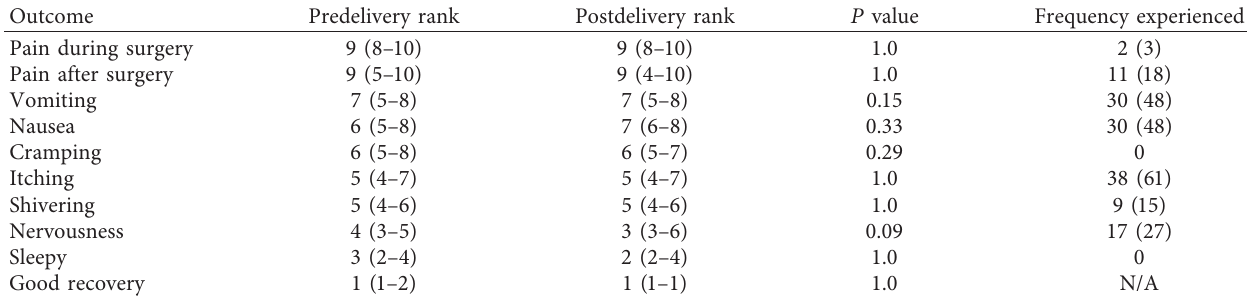
Table 2: Priority rankings for potential anesthesia-related side effects and their actual frequency.